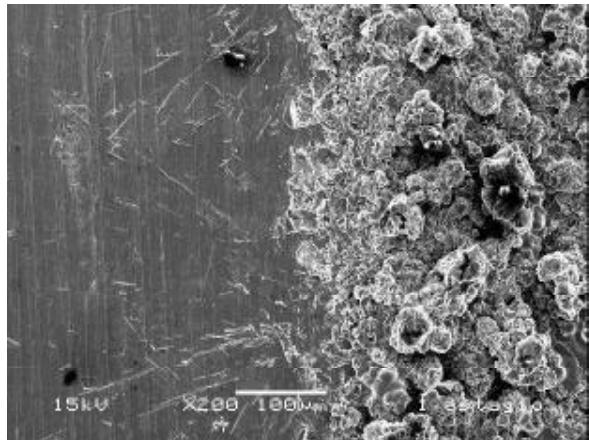
FIGURA 7- Superfície revestida por TPS. Observar distribuição desigual de partículas maiores (x1000)